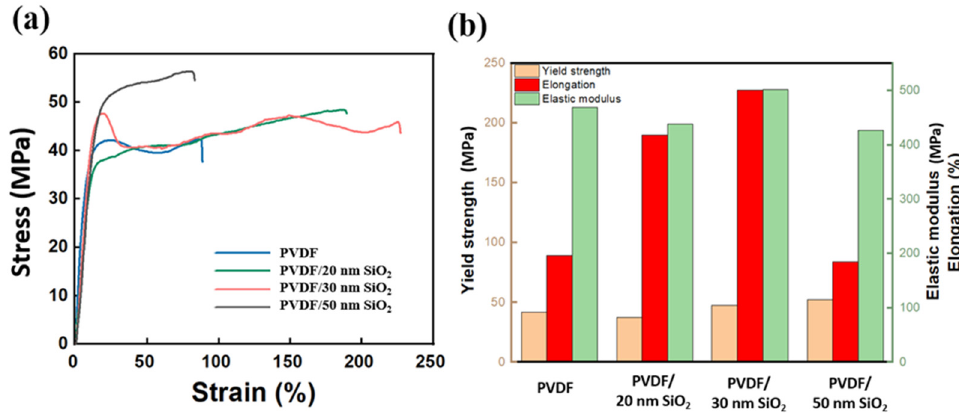
Figure 8. ( a ) Stress–strain curves of pure PVDF and PVDF/SiO 2 nanocomposites. ( b ) The yield strength, elastic modulus, and elongation of PVDF/0.5 wt% SiO 2 , with di ff erent particle diameters.